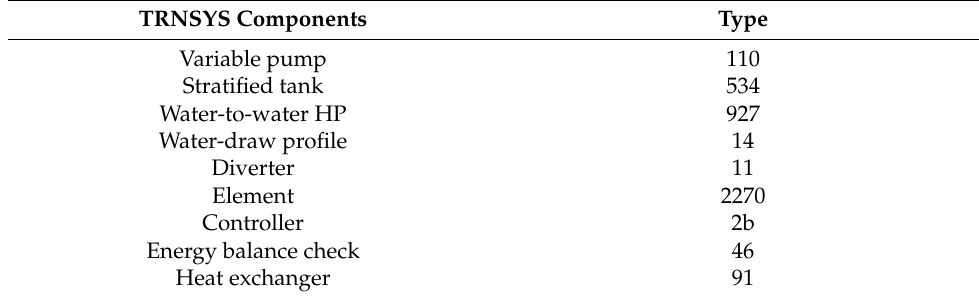
Table 6. TRNSYS components for MCST-HP and MCPVT-HP